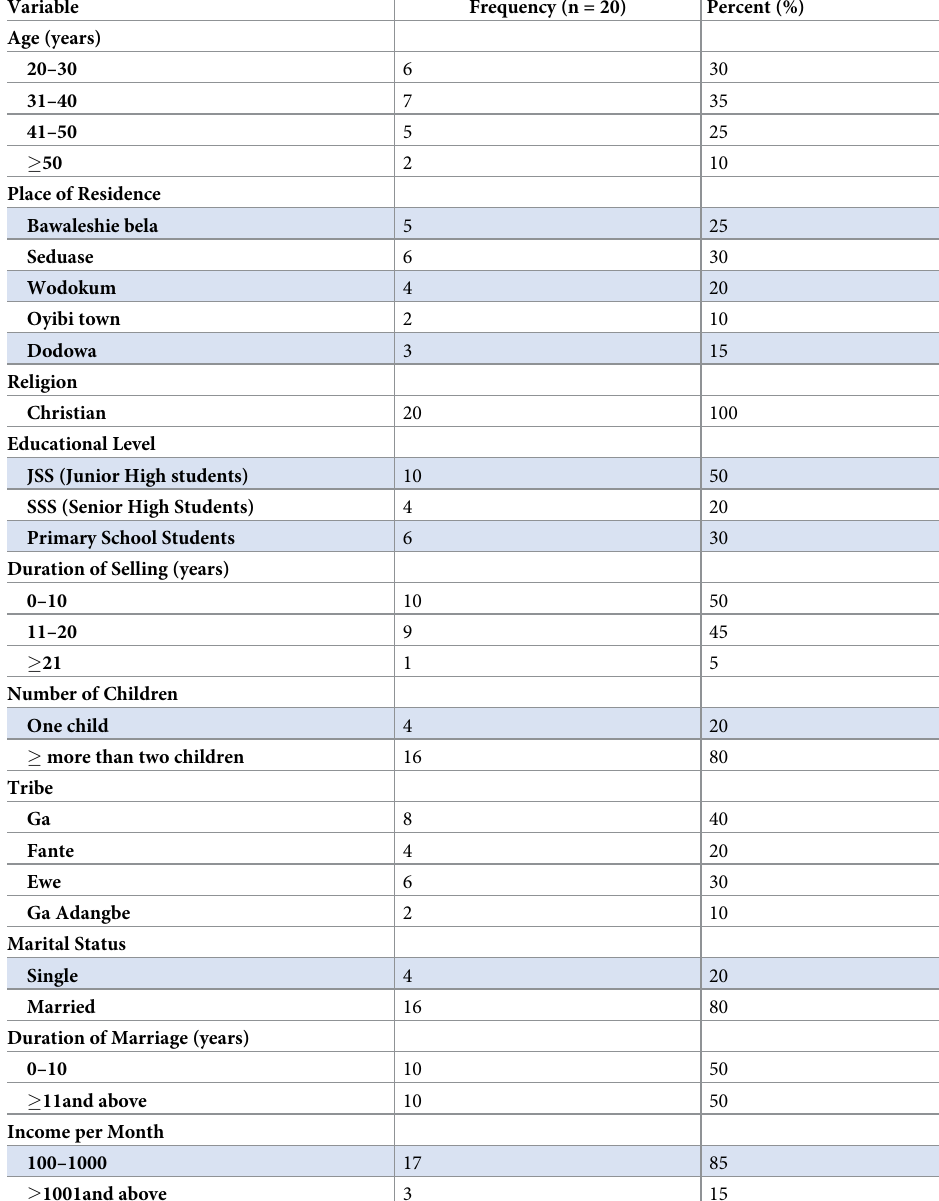
Table 1. Demographic characteristics of the